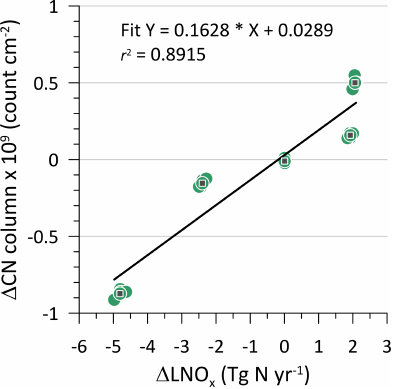
Figure 10. Same as Fig. 8, except for change in the modelled CH 4 ). lifetime ( (cid:49)τ CH 4